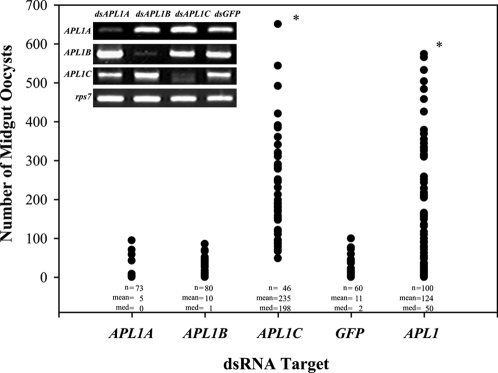
Among the APL1 family, only APL1C specifically protects against P. berghei infection.The three APL1 family genes were individually assayed to determine their relative contributions to host defense against P. berghei infection. Horizontal axis indicates the gene target of RNAi knockdown, where APL1A, B and C are gene-specific knockdowns, GFP is an irrelevant control dsRNA, and APL1 is a shared dsRNA that simultaneously knocks down all 3 APL1 family genes. Vertical axis indicates the number of midgut oocysts 7–8 d following IBM, with sample size (n), mean (mean), and median (med). Infection levels in APL1A and APL1B silenced mosquitoes were not different from GFP controls. However, treatment with either dsAPL1C or dsAPL1 (targeting all 3 genes) permitted significantly greater oocyst development than the other treatments (asterisk, p<0.05 by Dunn's Multiple Comparison after Kruskal Wallis one way ANOVA on ranks). Infections of APL1C and APL1 silenced mosquitoes were not different from each other, indicating that the function of APL1C alone is sufficient to explain all of the increased permissiveness caused by complete APL1 family knockdown. The result for each knockdown target represents pooled data from at least 2 independent replicate experiments. One of the common APL1 knockdowns was done alongside an APL1C kd, and when assayed in the same replicate, there was no significant difference between APL1C kd and common APL1 kd (p = 0.481). The inset gel photo shows representative examples of gene knockdown efficiency for the 3 members of the APL1 gene family. Labels above gel images indicate the dsRNA that was used for the knockdown. Labels to the left of images indicate the transcript detected by RT-PCR on RNA purified from the treated mosquitoes. rps7 was used as a control for cDNA input in PCR.